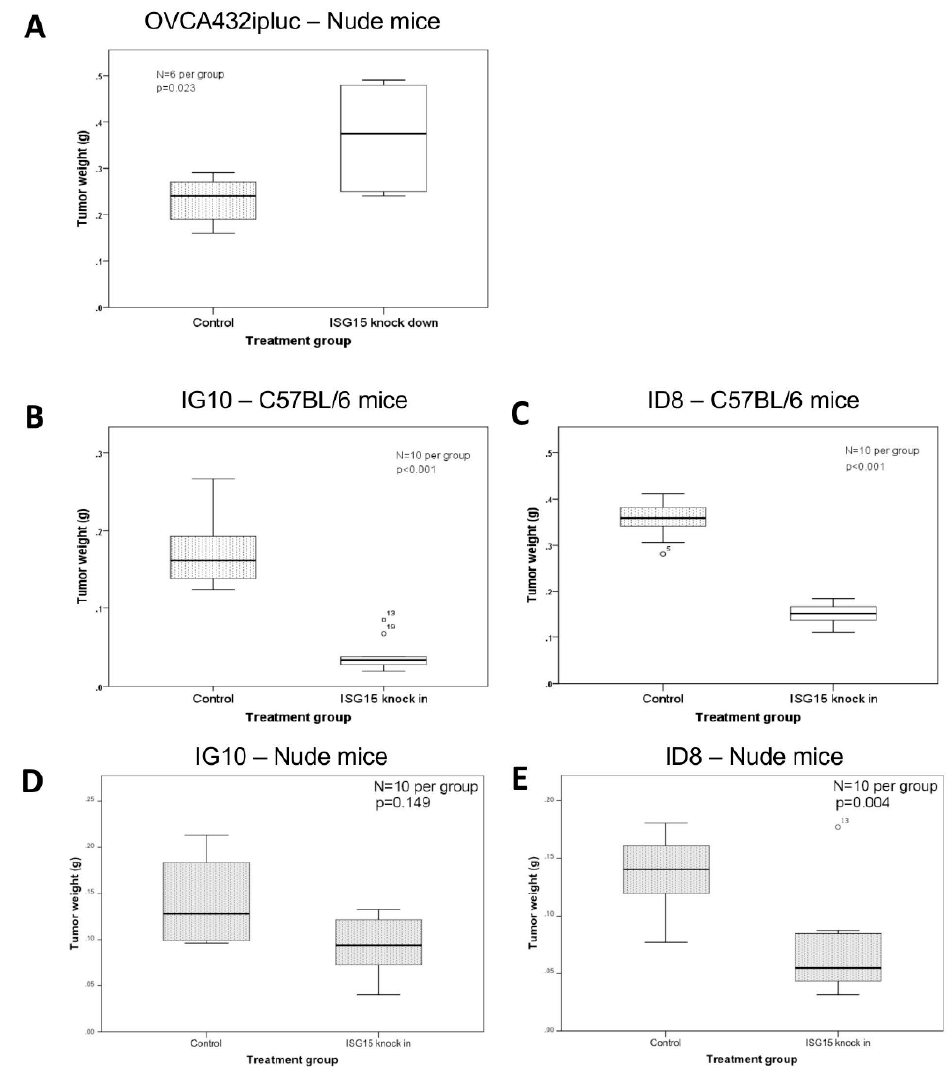
Figure 4. ISG15 overexpression suppresses ovarian cancer growth in orthotopic mouse models. ( A ) OVCA432 ovarian cancer cells were intraperitoneally injected into athymic nude mice. A significant increase in tumor burden was observed in mice injected with OVCA432 cells transduced with the ISG15 specific shRNA when compared with scrambles shRNA transduced control mice. To further evaluate the effect of ISG15 overexpression on ovarian cancer growth in an immune-competent microenvironment, mouse ovarian cancer cell lines ( B ) IG10 and ( C ) ID8 transduced with the full-length mouse ISG15 expression construct were intraperitoneally injected into immuno-competent C57BL/6 mice. Animal study results indicated a significant decrease in tumor weight for mice injected with cell lines transduced with the full length ISG15 expression construct when compared with those transduced with the control vector. To evaluate the effects of ISG15 expression on ovarian cancer progression in a T cell-depleted environment in vivo, both ( D ) IG10 and ( E ) ID8 cell lines were injected into C57BL/6 nude mice. The results showed a significant decrease in tumor size in mice injected with ISG15 transduced cancer cells when compared to those injected with the mock-transduced cells.